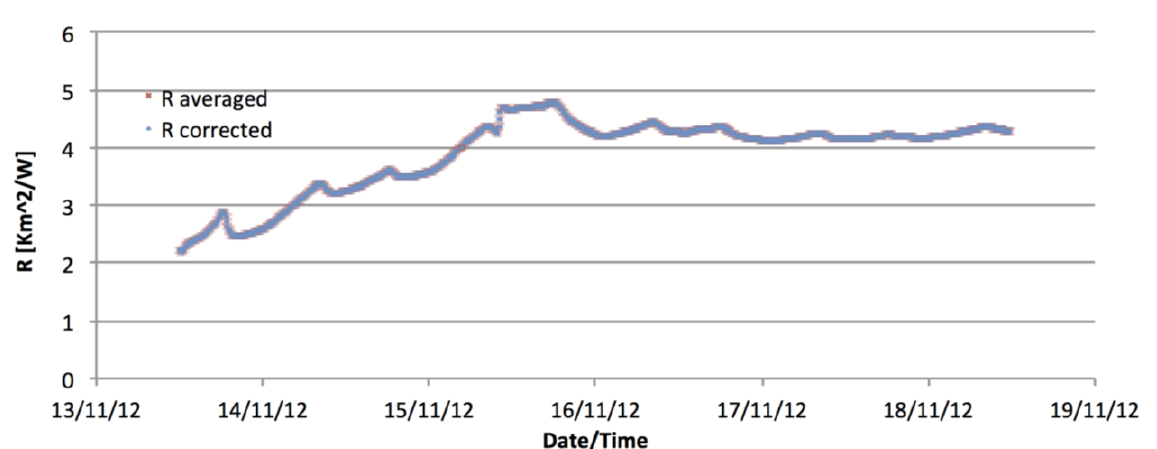
Figure 4. U -value test—thermal